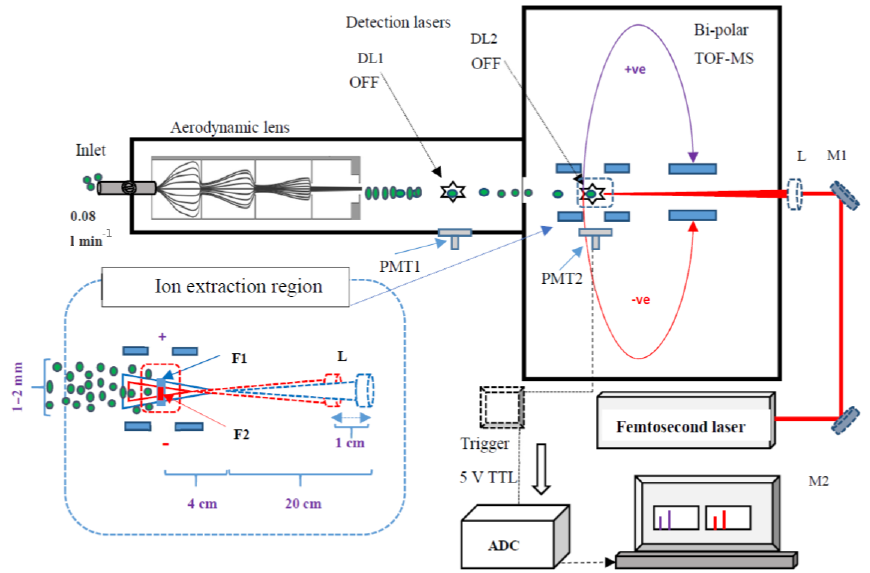
Figure 1. Schematic diagram of the LAAPTOF coupled with the fs laser. The detection lasers DL1 and DL2 are turned off, as well as the first set of PMT (PMT1). PMT2 collects the scattered light from the interaction of the fs laser with the particle. The PMT2 signal is connected to the trigger box and produces a trigger with a 5V TTL signal for the ADC data acquisition. M1 and M2 are mirrors, and the aerosol particles are shown as green dots. The corresponding spectra of each ablated particle are recorded and stored in the computer. The inset picture shows the centre of ion extraction region (dashed red square) and the variation in laser beam diameters for the two different lens or focus positions (F1 blue and F2 red). The laser focus is 3–4cm before the ion extraction region. The counter-propagating particle beam (green dots) has a diameter of 1–2mm depending on the particle type. Moving the lens 1cm towards the ion extraction region (F2) reduces the beam diameter and increases the power density at the centre of the extraction region. Picture is not to the exact